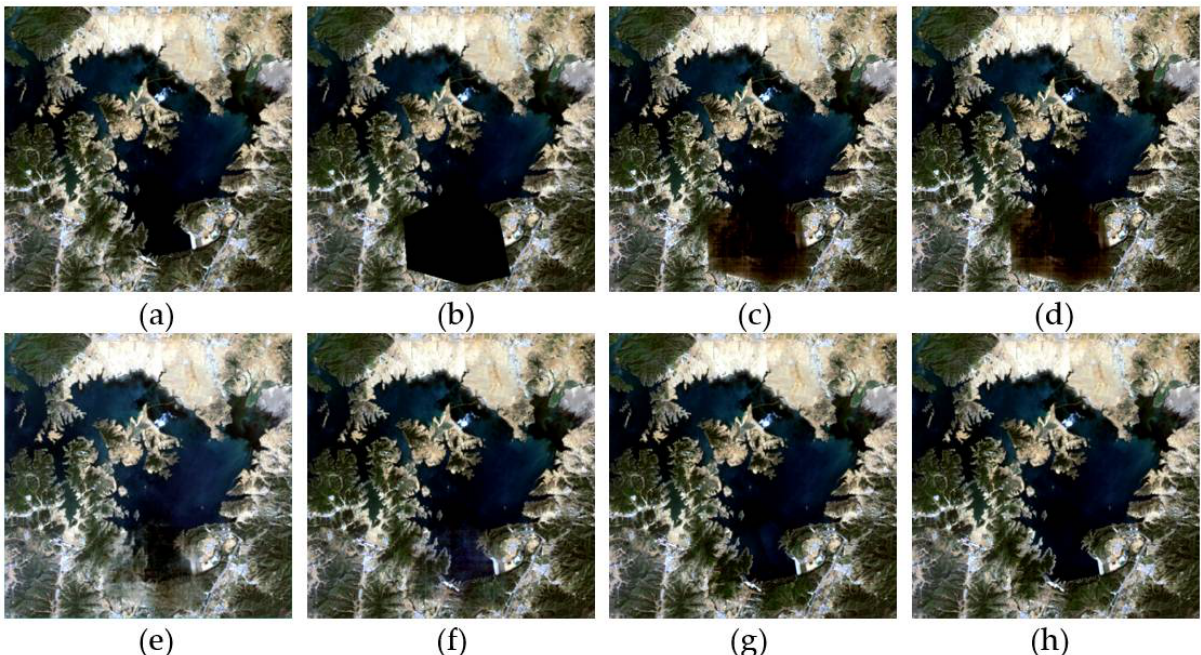
Figure 11. The simulated experiment performed on dataset 4: ( a ) original image; ( b ) simulated cloudy image, ( c – h ) reconstructed images of HaLRTC, AWTC, NL-LRTC, TVLRSD, ST-Tensor and FMTC algorithms, respectively.